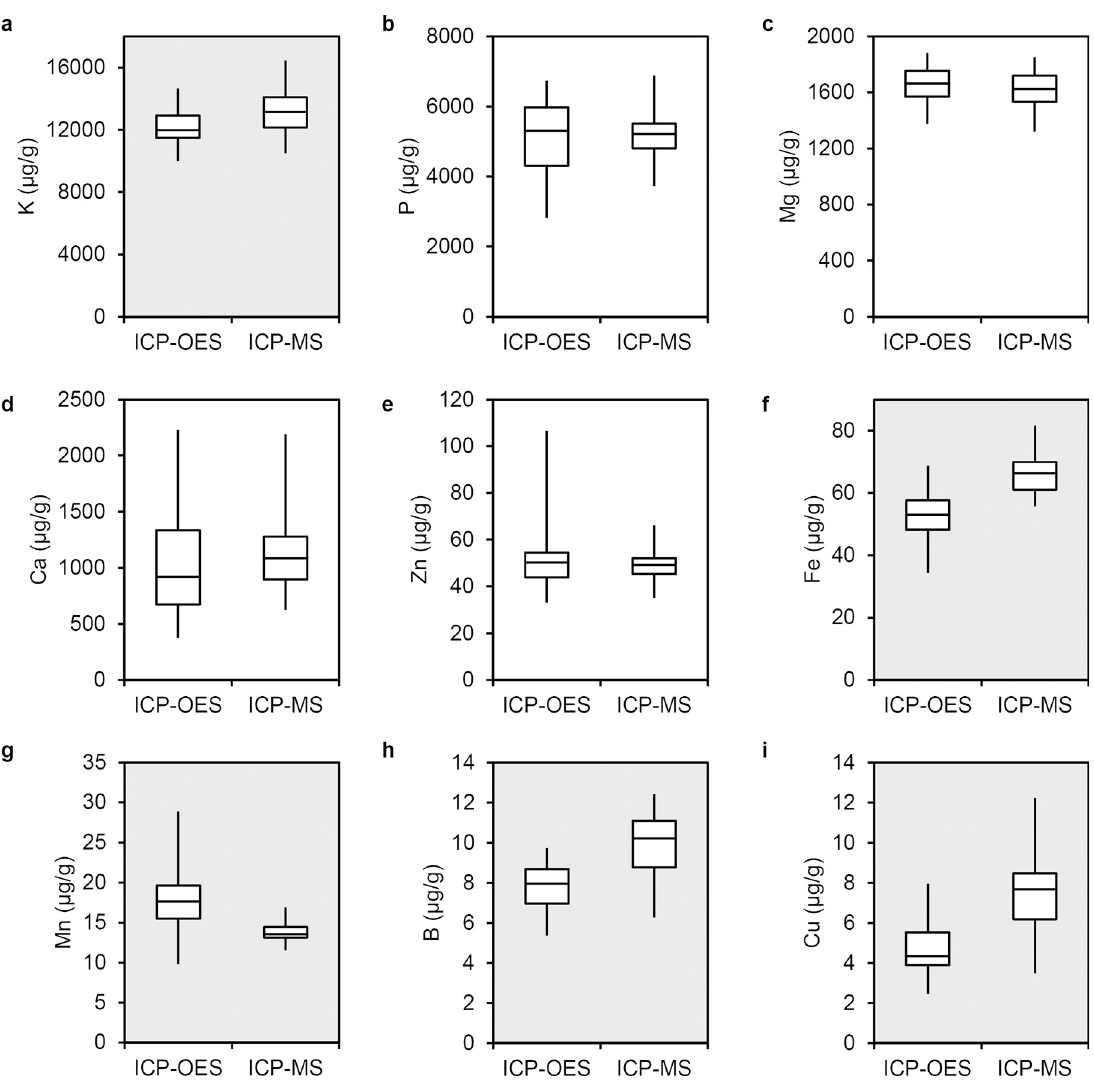
Fig 4. Boxplots comparing concentration data of elements from 30 pea accessions analyzed in this study with ICP-MS to prior ICP-OES data [26]. Plots with a gray background show significant mean differences with p < 0.01 for a paired Student’s t-test. Plots are ordered by descending average concentration: (a) K, (b) P, (c) Mg, (d) Ca, (e) Fe, (f) Zn, (g) Mn, (h) B, and (i)